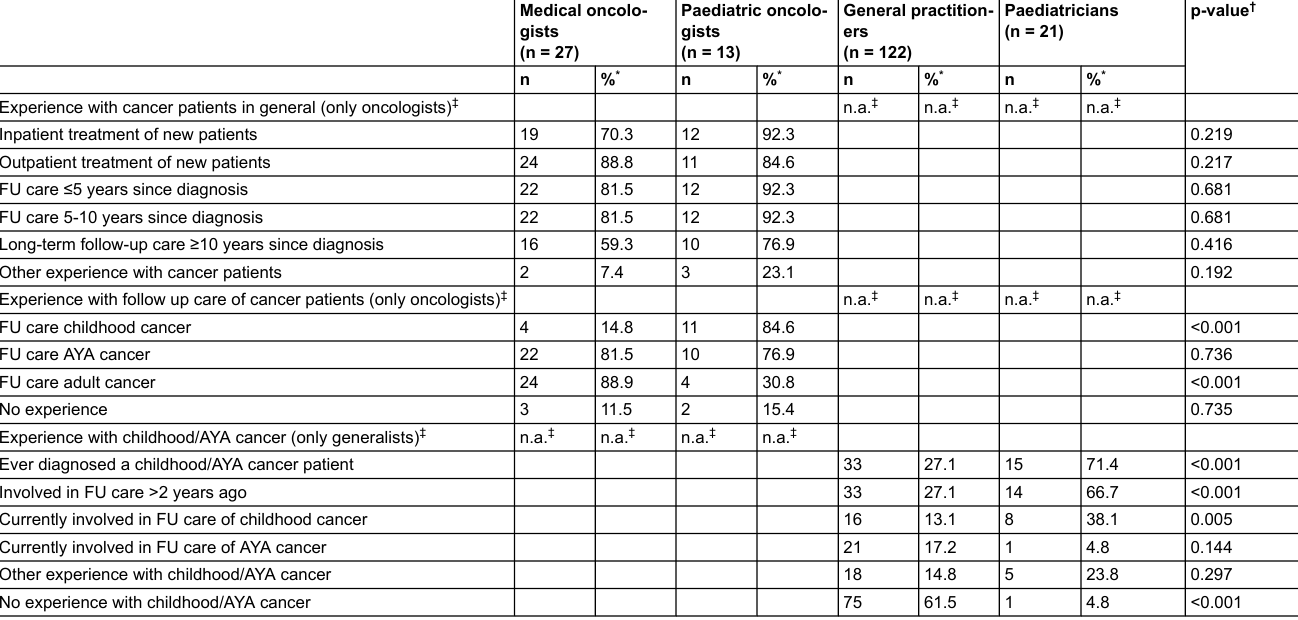
Table 2: Physicians’ experience with childhood, adolescent and young adult cancer patients and their follow-up care.